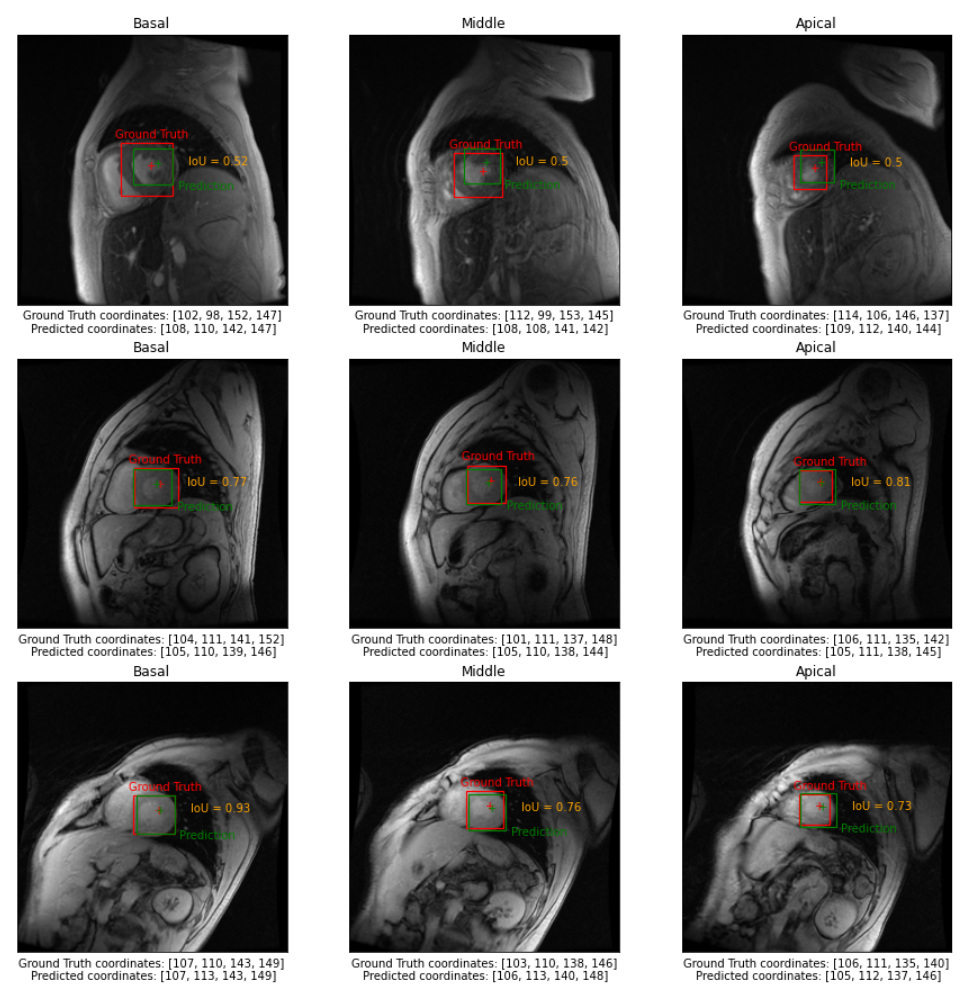
Figure 3. Examples of the model’s output in three different subjects belonging to the test set in basal, middle, and apical